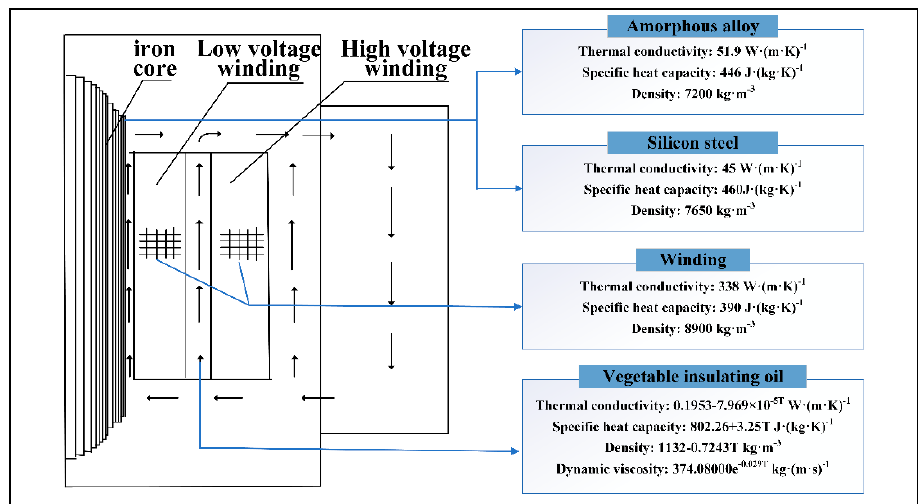
Figure 3. Schematic diagram of the natural circulation of oil. Table 1. Parameters of the simulation model.